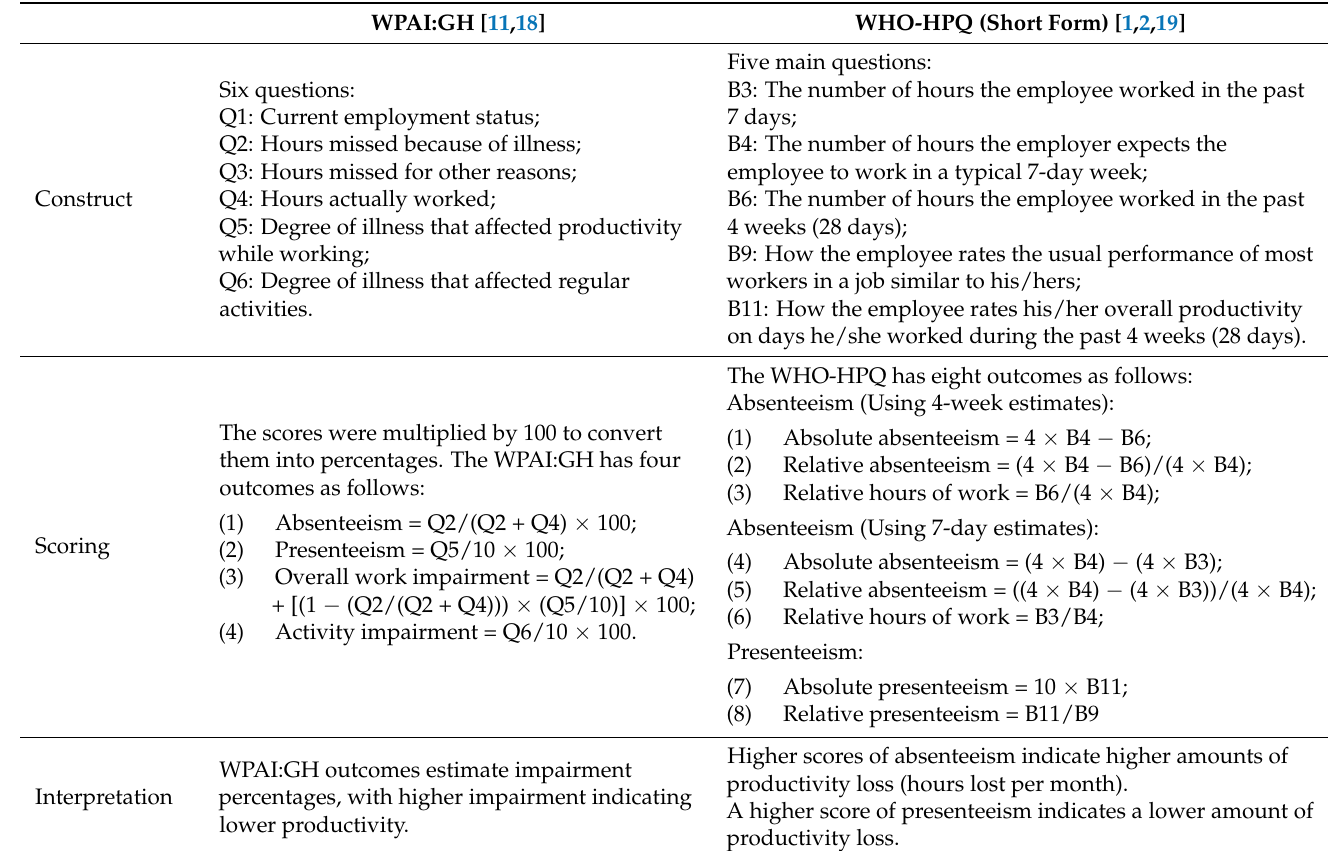
Higher scores of absenteeism indicate higher amounts of productivity loss (hours lost per month). A higher score of presenteeism indicates a lower amount